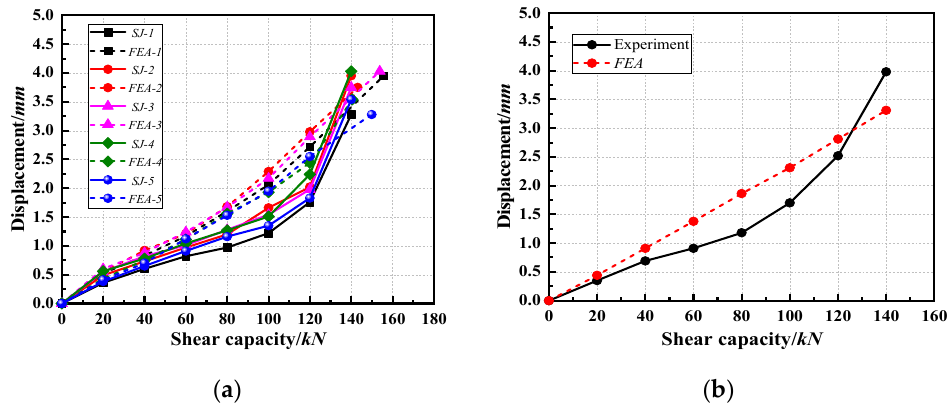
Figure 20. Finite element analysis of sleeve shear capacity: ( a ) Original data; ( b ) average values.